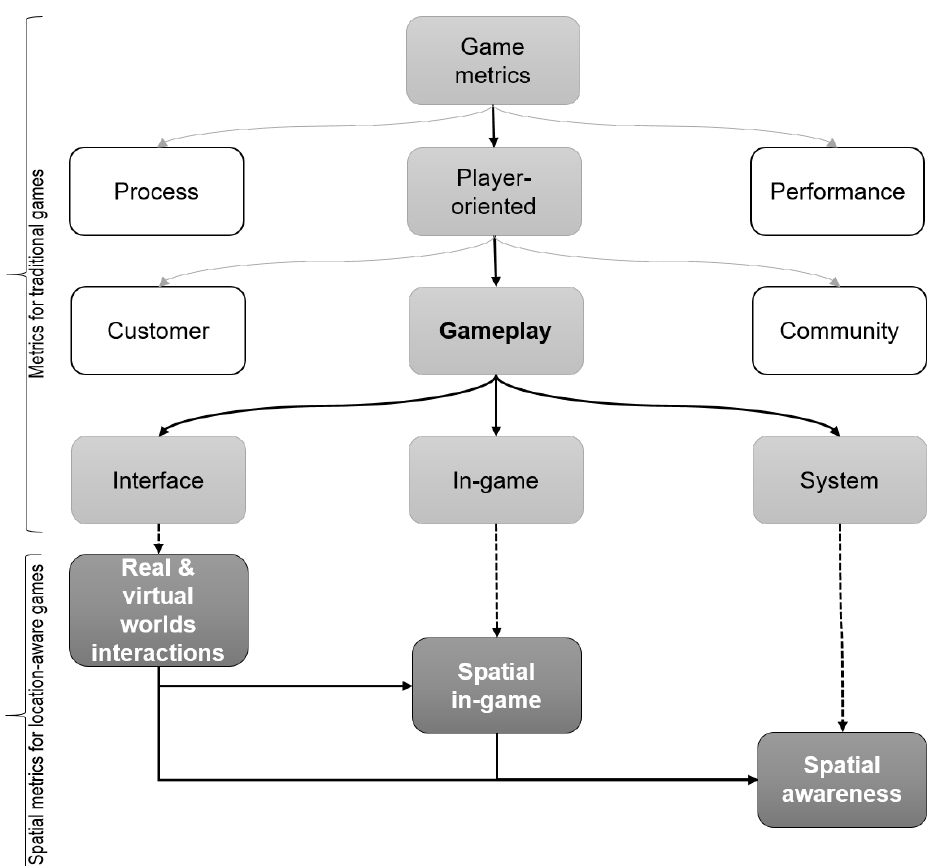
Figure 2. Spatial metrics classification embedded into existing classification of game metrics centered on gameplay/player (extended from